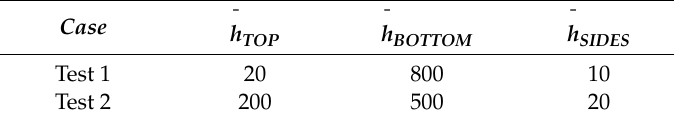
Table 7. Heat transfer coe ffi cients definition (W / (m 2 .K)).